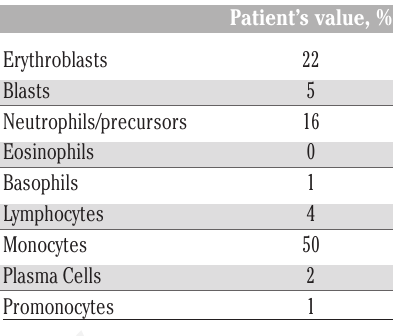
Table 3. Bone marrow differential count.